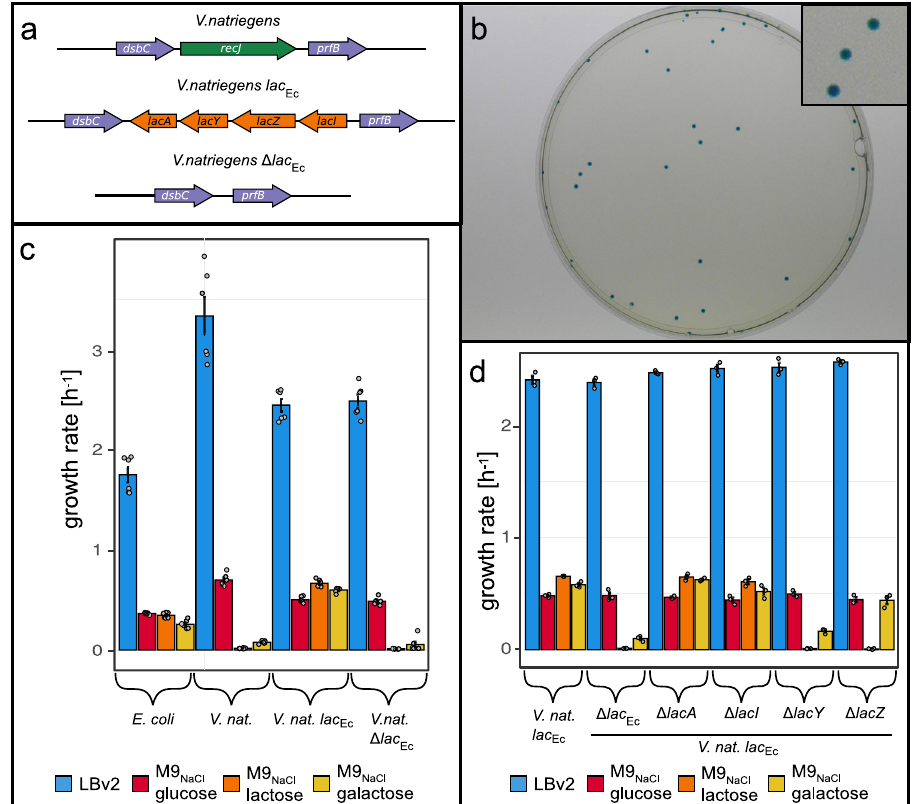
Fig. 8 Functionality of the E. coli lactose operons in V. natriegens . a Shown is the gene map of the V. natriegens strains tested for lactose metabolism. The native recJ gene is replaced by the E. coli lac operon in V. natriegens lac Ec . This strain was further edited by the elimination of the lac Ec operon resulting in V. natriegens Δ lac Ec , which is also a Δ recJ knock out. b Shown is a picture of V. natriegens colonies, harbouring the E. coli DH5 α lac operon, transformed with a plasmid containing the lacZ α fragment. Cells were plated on LBv2 agar supplemented with IPTG and X-gal. c Shown are the growth rates of V. natriegens strains and E. coli grown in different media and carbon sources. For each sample, six independent replicates were performed. Cells were grown in M9 minimal medium supplemented with either 0.4% glucose (red), lactose (orange) and galactose (yellow) as well as in LB ( E. coli )/LBv2 medium ( V. natriegens ) (blue) using a microplate reader. Data are presented as mean values ± SEM. d Shown are the growth rates of V . natriegenslac EC strain and knockouts of the lac operon and of each gene in the lac operon grown in different media and carbon sources. For each sample, three independent replicates were performed. Cells were grown in M9 minimal medium ( + 2% NaCl) supplemented with either 0.4% glucose (red), lactose (orange) and galactose (yellow) as well as in LB ( E. coli )/LBv2 medium ( V. natriegens ) (blue) using a microplate reader. Data are presented as mean values± SEM. Source data are provided as a Source data fi